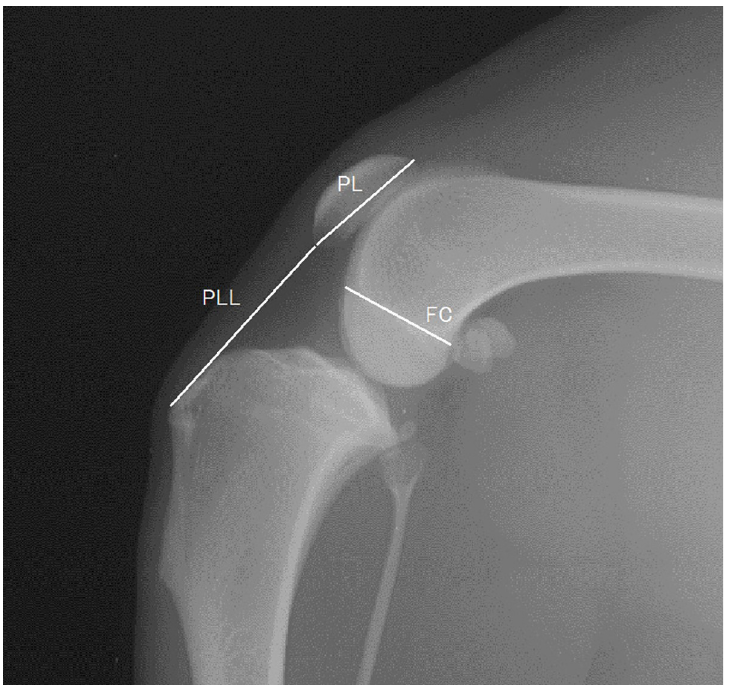
Fig 2. The measurement definitions of the patellar length (PL), patellar ligament length (PLL), and size of the femoral condyle (FC). The PL was measured as the longest dimension of the patella. The PLL was measured from the most distal portion of the patella to the patellar ligament insertion on the cranioproximal portion of the tibial tuberosity. The FC was measured from the origin of the long digital extensor muscle to the caudal femoral cortex along the Blumensaat’s